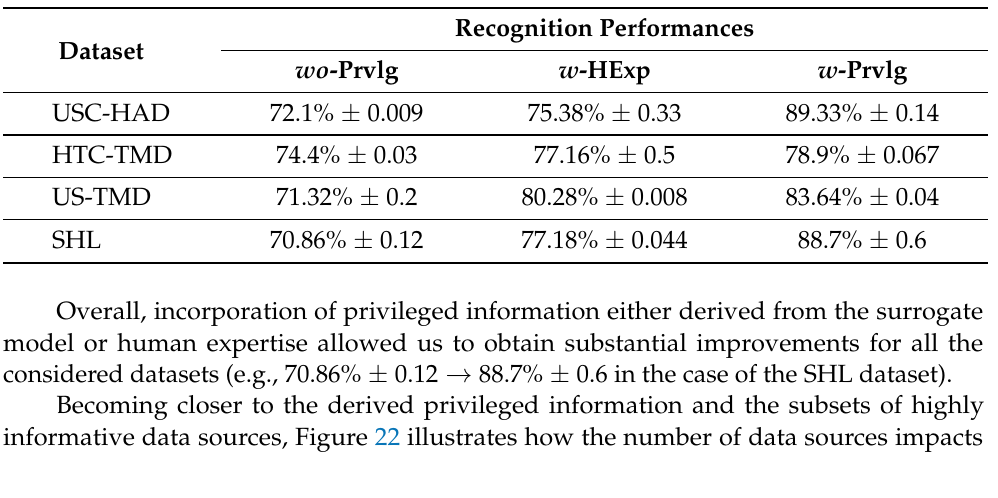
Table 5. Comparison of different privileged settings in terms of recognition performances on four different datasets USC-HAD, HTC-TMD, US-TMD, and SHL. Privileged information are derived from the surrogate model constructed by using the data featured in the SHL dataset. Scores of column w -prvlg correspond to top-performing models selected while varying the data source im- portance threshold τ imp . Recognition performance means and variances are reported on a total of 10 experiments